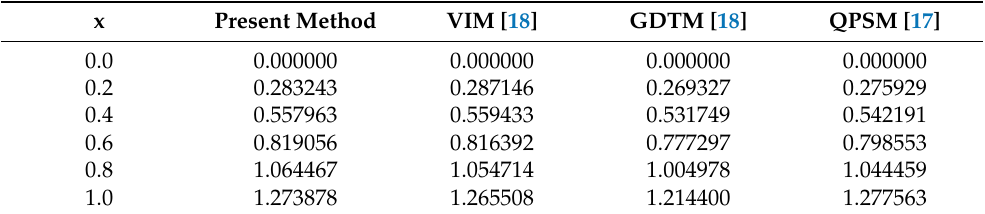
Table 3. The comparison between the proposed method and other existing methods for t = 0.4 and various x values.